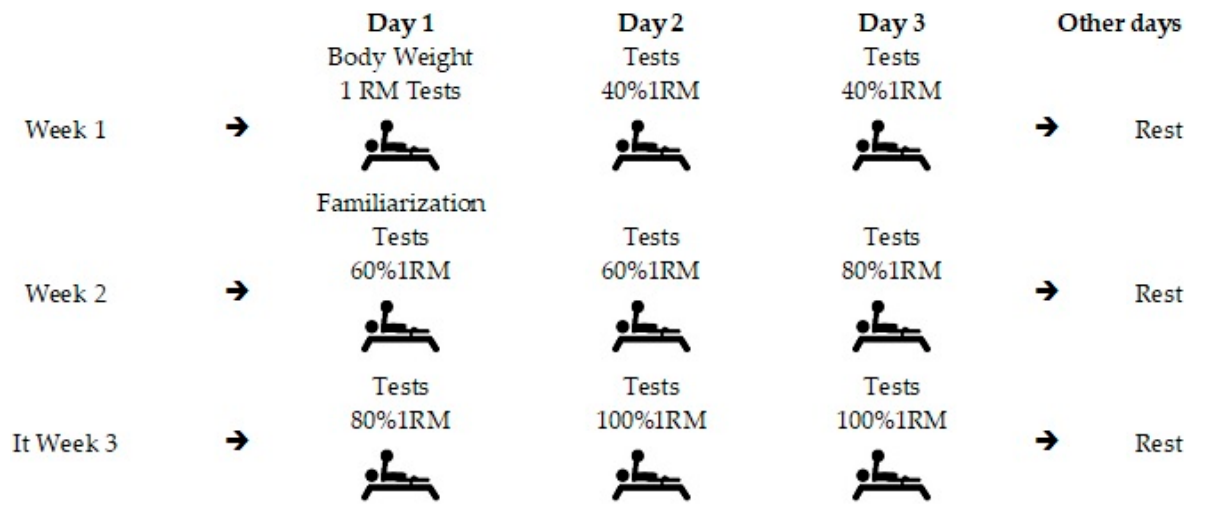
Figure 1. Experimental sequence—planning weekly tests. The tests were in relation to sEMG, MaxV, MPV and power.